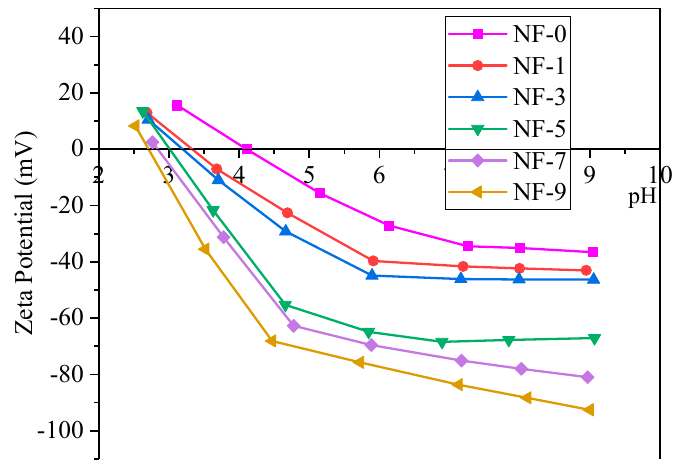
Figure 5. Zeta potential of NF membranes with different DWCNT dosages.